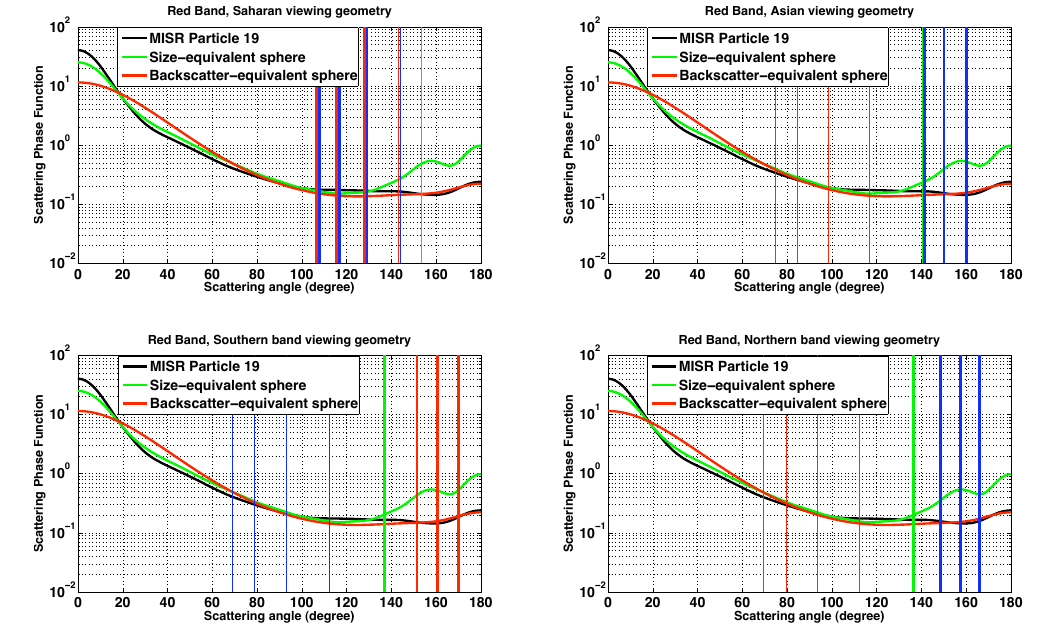
Fig. 11. Scattering phase functions for the MISR red wavelength for MISR Particle 19 (medium dust) compared with two additional spher- ical particles, a size-equivalent sphere and a backscattering-equivalent sphere. Different panels correspond to different viewing geometries indicated by the boxes in Fig. 10. (a) Saharan dust transport, (b) Asian dust transport, (c) Southern Hemisphere enhanced non-sphericity band, and (d) Northern Hemisphere enhanced non-sphericity band. Vertical lines indicate scattering angles observed by different MISR cam- eras with forward-looking cameras shown in red, aftward-looking cameras shown in blue, and the nadir camera shown in green. Thin lines indicate cameras with glitter angles within 40 ◦ of the specular direction not used in the the MISR Dark Water